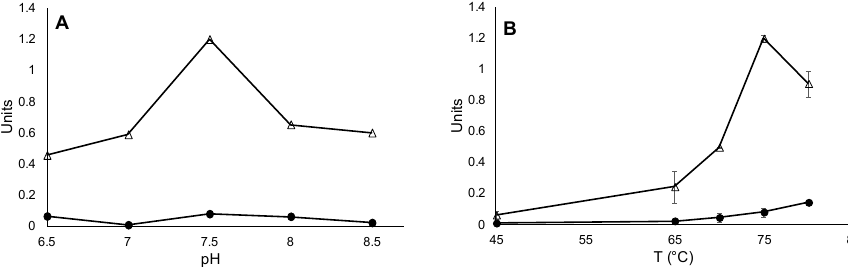
Figure 1. Determination of Sb. thermosulfidooxidans Sor properties in crude extracts. Optimal pH values ( A ); and temperature ( B ) were determined for the oxygenase (triangles) and reductase (circles) enzyme activities. In ( A ) experiments were done at 75 °C; and in ( B ) at pH 8. Standard deviation values from triplicates are